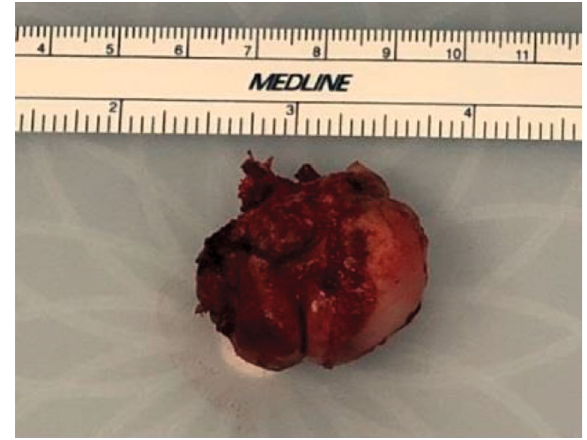
Figure 4: Intraoperative osteochondroma gross specimen. This photograph demonstrates the solitary lesion after it was fully excised from the pelvis (Osteochondroma Gross Specimen.jpg).